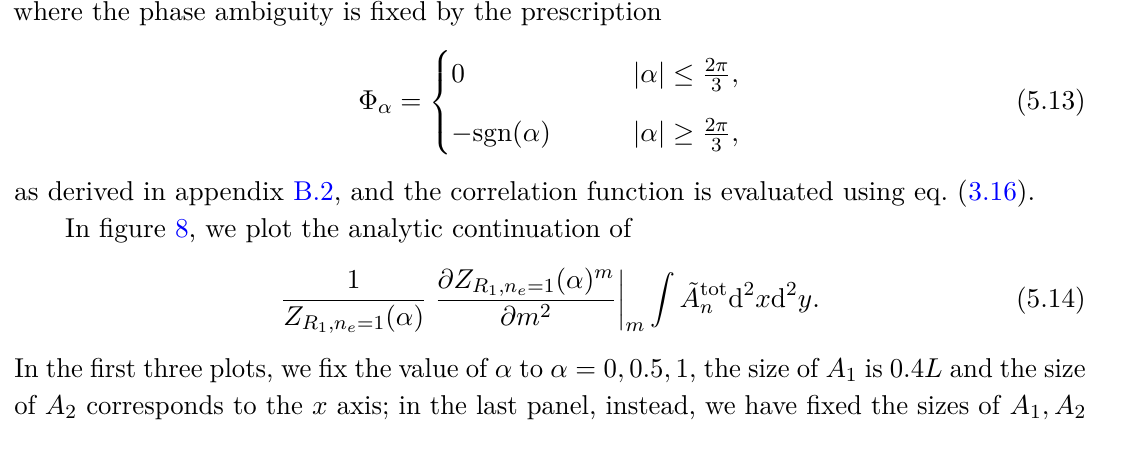
Figure 8 . Top and bottom left: massive correction to the partial transposed moment Z R 1 n e = 1 , β = 10 , as a function of the length of the interval A 2 , ‘ 2 . A 1 and A 2 are two adjacent intervals, where the size of A 1 is fixed and equal to 0 . 4 (we chose the total spacial length of the system to be L = 1 with N = 300 sites). The value of α is fixed and shown in the legend. In blue we plot the field theory prediction, in orange the lattice data. Bottom right: α -dependence of the massive correction for the partial transposed moment. The subsystems are adjacent and their size is fixed to be ‘ 1 = 0 . 4 and ‘ 2 = 0 . 3 . The blue points are the field theory prediction in eq. (5.14), while the solid orange line describes the lattice